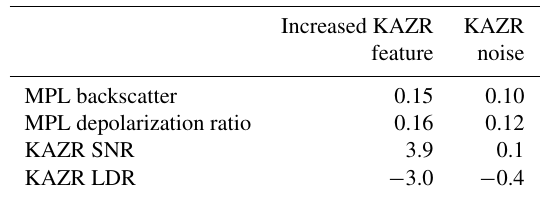
Table 2. Mean values of four quantities for increased KAZR feature and noise pixels.